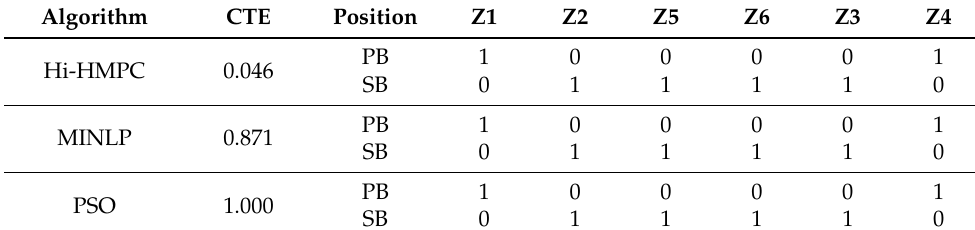
Figure 7. Schematic view of SPS under fault scenario 2. Table 5. Switch configuration in fault scenario